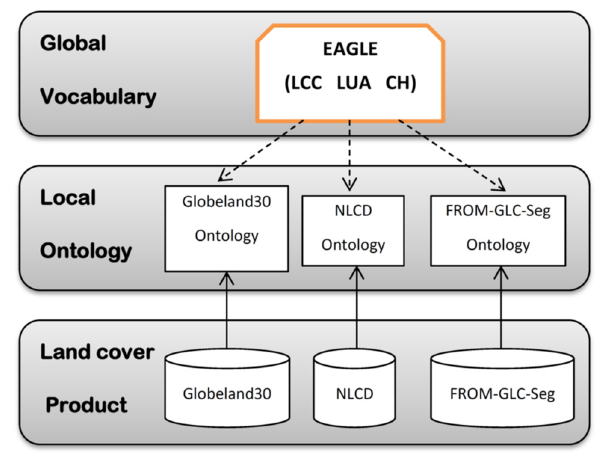
Figure 1. Ontology construction diagram. The black arrows represent transformation or access to the data, and the dotted arrows represent implicit relations.